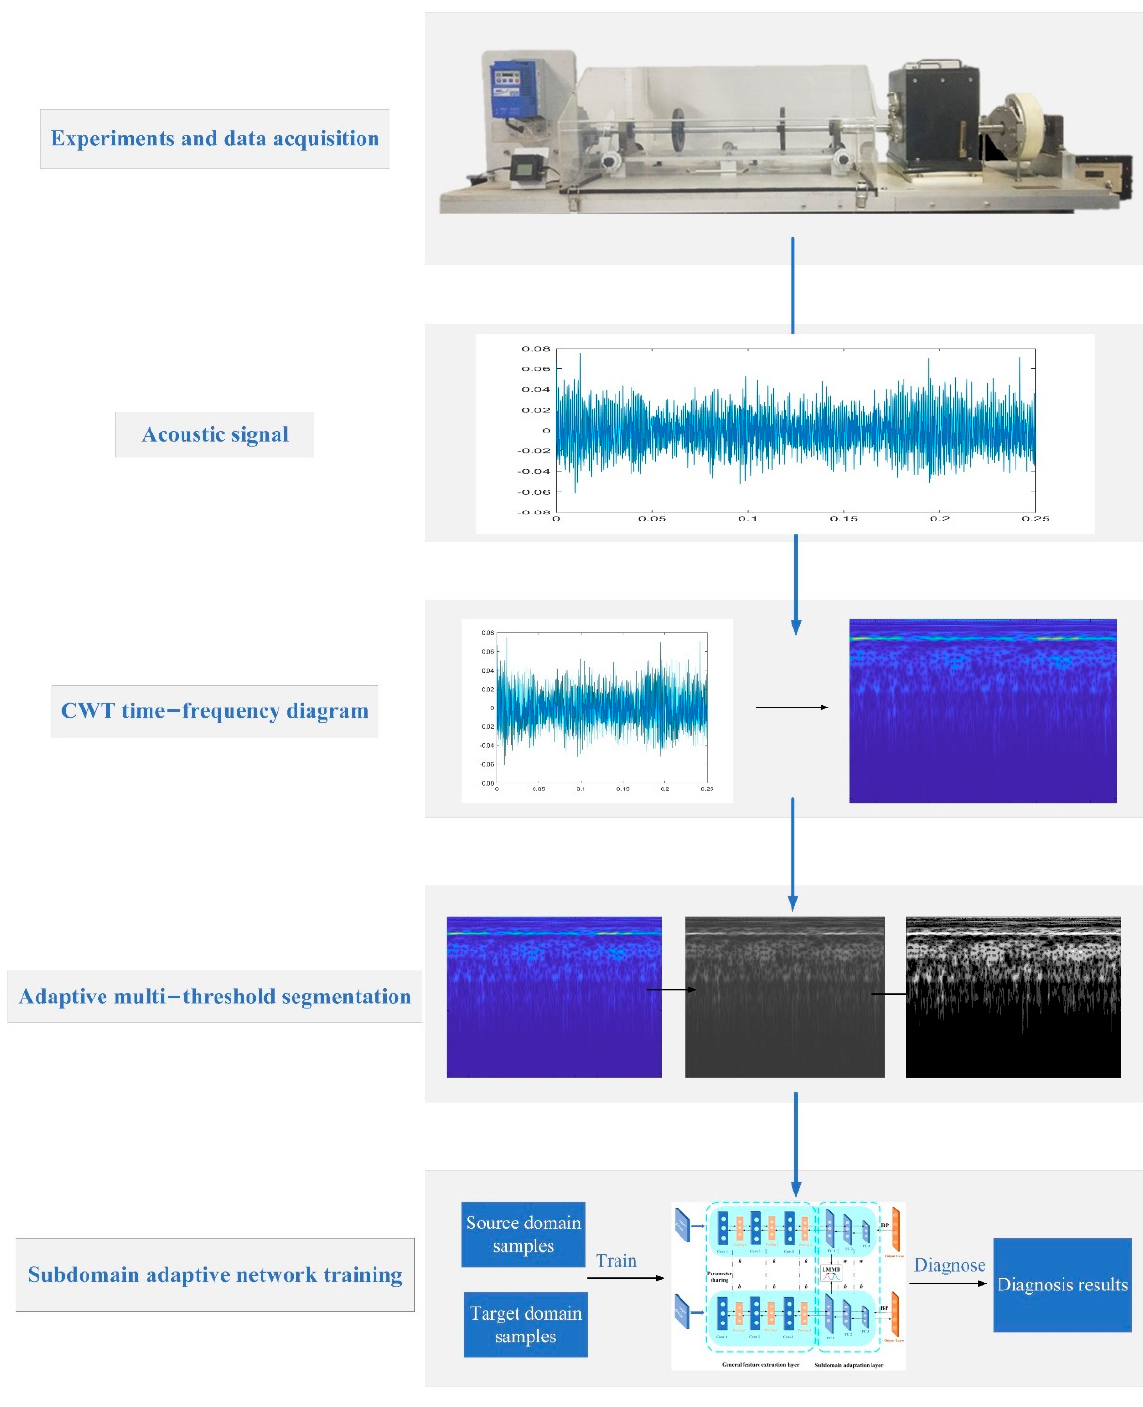
Figure 9. Fault diagnosis strategy flowchart.